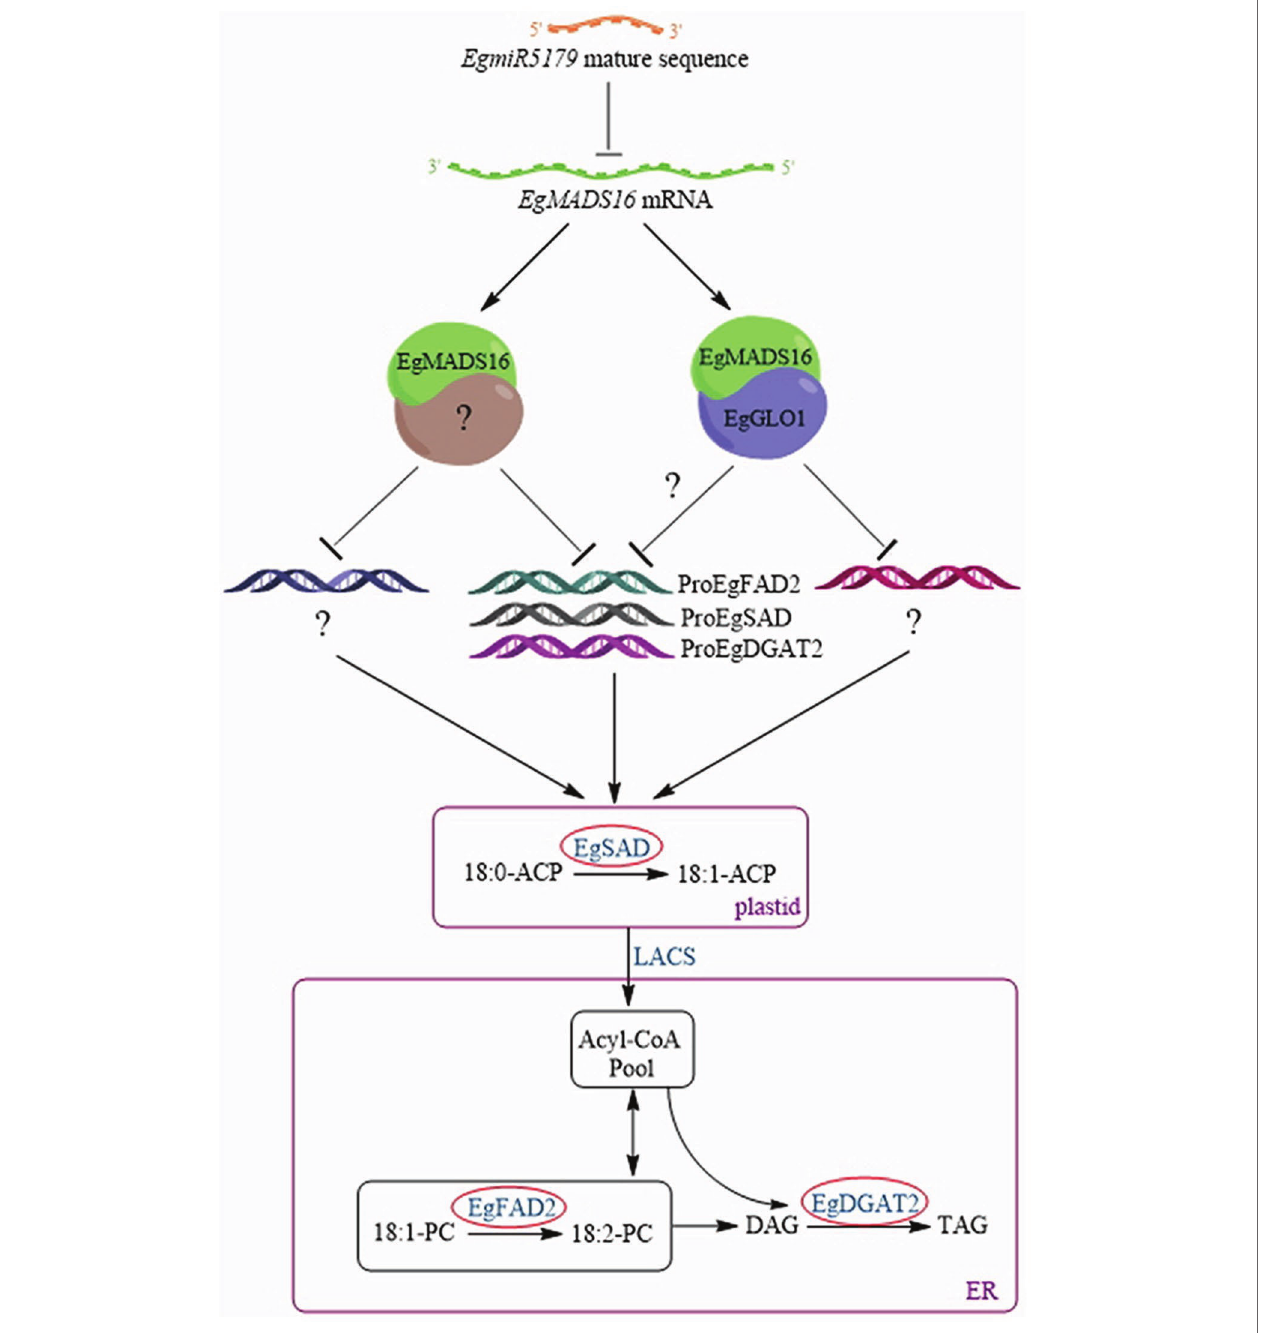
FIGURE 9 | A model about the molecular mechanism of EgMADS16 regulating oil biosynthesis. EgMADS16 protein forms a complex with EgGLO1 or other proteins and binds to the promoter of EgFAD2 or EgSAD or EgDGAT2 or other oil biosynthesis-related genes, inhibiting the transcription of these genes and affecting fatty acid components and oil accumulation. However, EgmiR5179 targets to EgMADS16 mRNA and inhibits its expression, so that the oil accumulation is